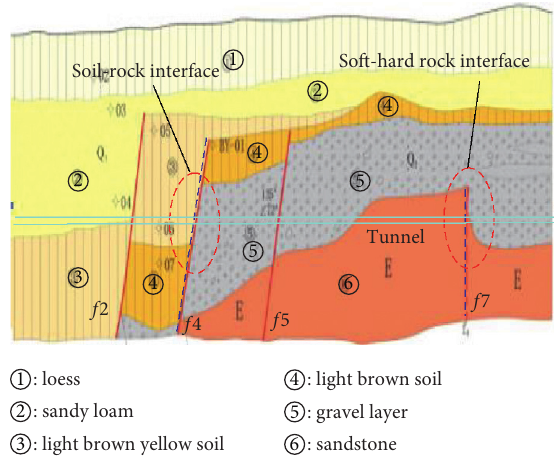
Figure 1: Geological conditions of interface section of soft and hard